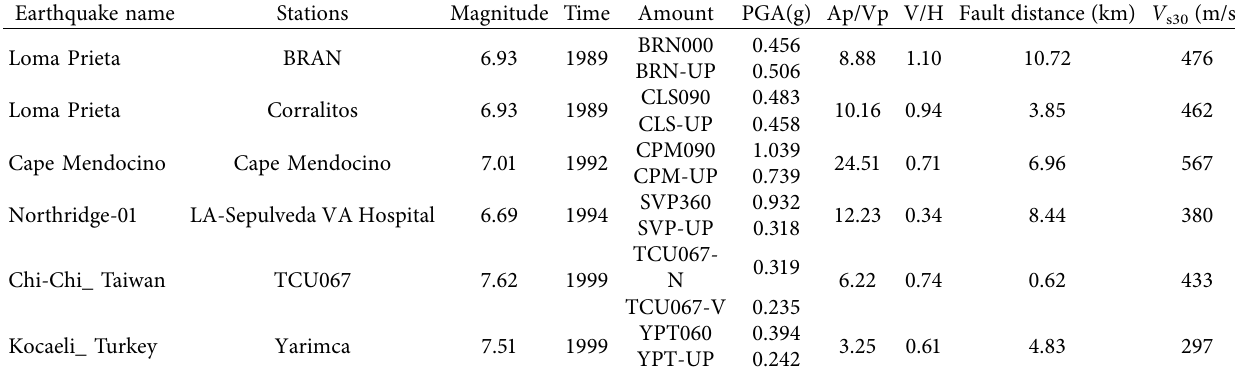
Table 2: Nonimpulse type NF ground vibration information table.